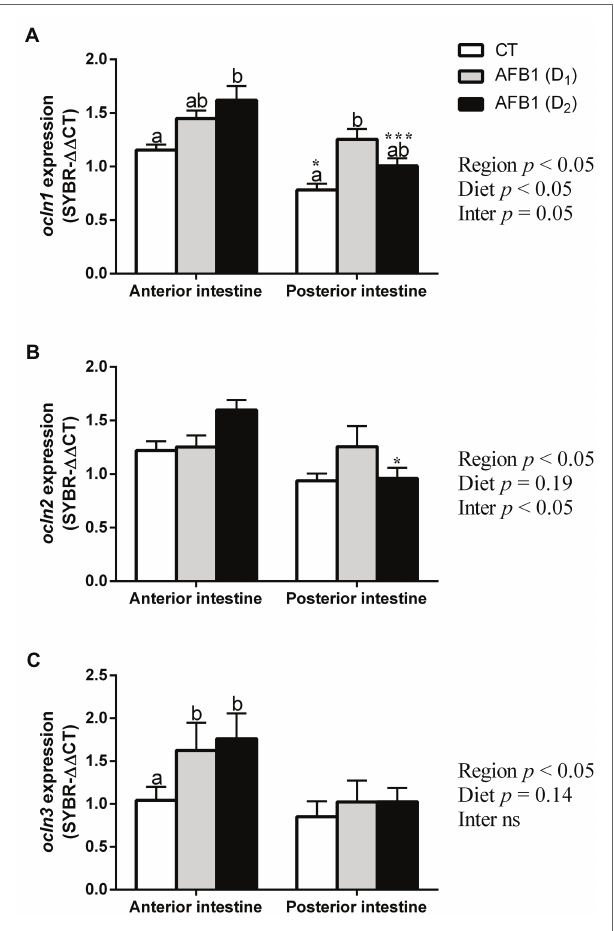
FIGURE 5 | Gene expression of ocln1 (A) , ocln2 (B) , and ocln3 (C) , in the anterior (AI) and posterior intestine (PI) of S. aurata juveniles fed with different experimental diets (CT, control; D 1 , 1 mg- and D 2 , 2 mg-AFB1 kg − 1 fish feed) for 85 days. Data are presented as mean ± SEM (n = 8–10). Further details in legend Figure 4 .